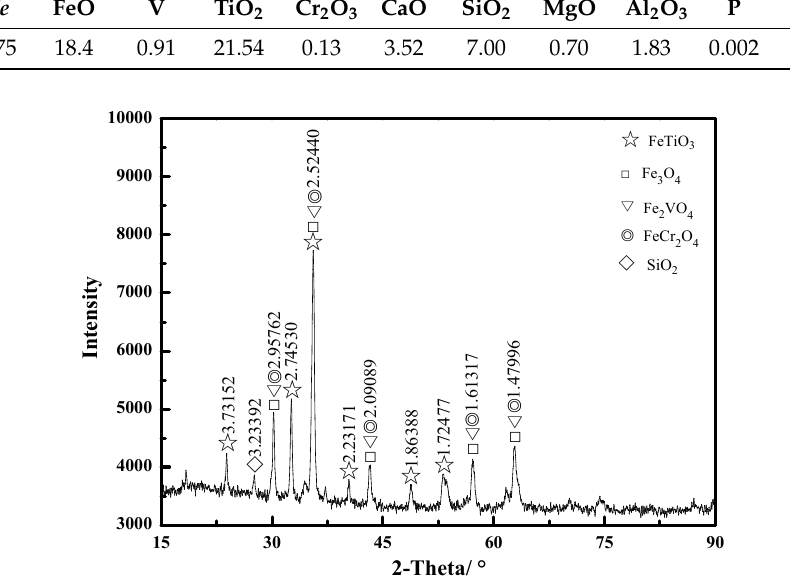
Table 1. Chemical composition of LGVTM (wt %).